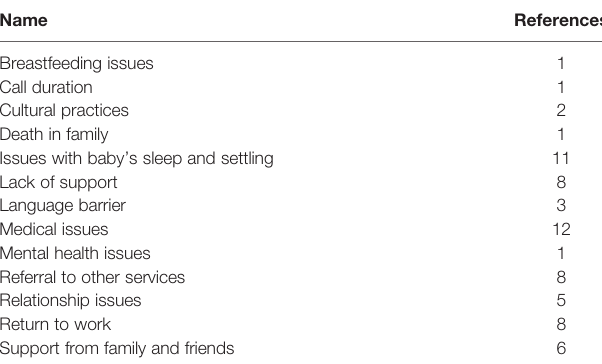
TABLE 2 | Comparisons of the socio-demographic characteristics between those who had high, medium and low levels of engagement. Mother ’ s baseline demographics